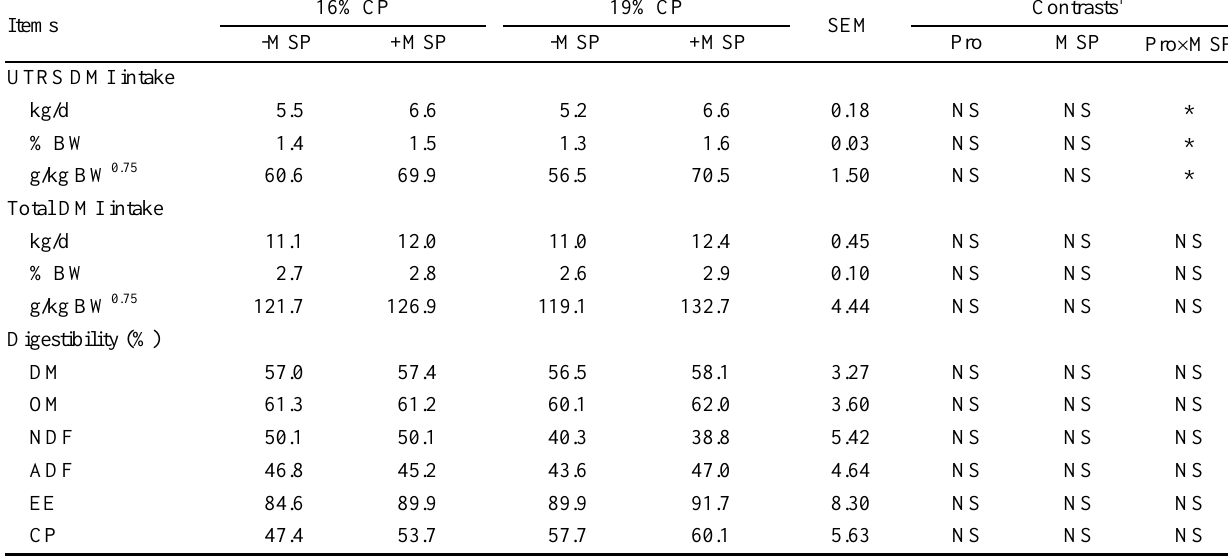
Table 2. Effect of protein level and mangosteen peel pellets (Mago-pel) in concentrate on voluntary feed intake and nutrient digestibility 16% CP Items